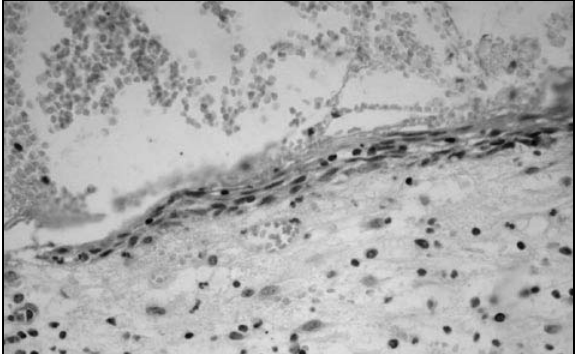
Figura 3 – Imunopositividade difusa no componente epitelial e focal no mesênquima para MMP-2 em cisto dentígero (SABC, 200x)